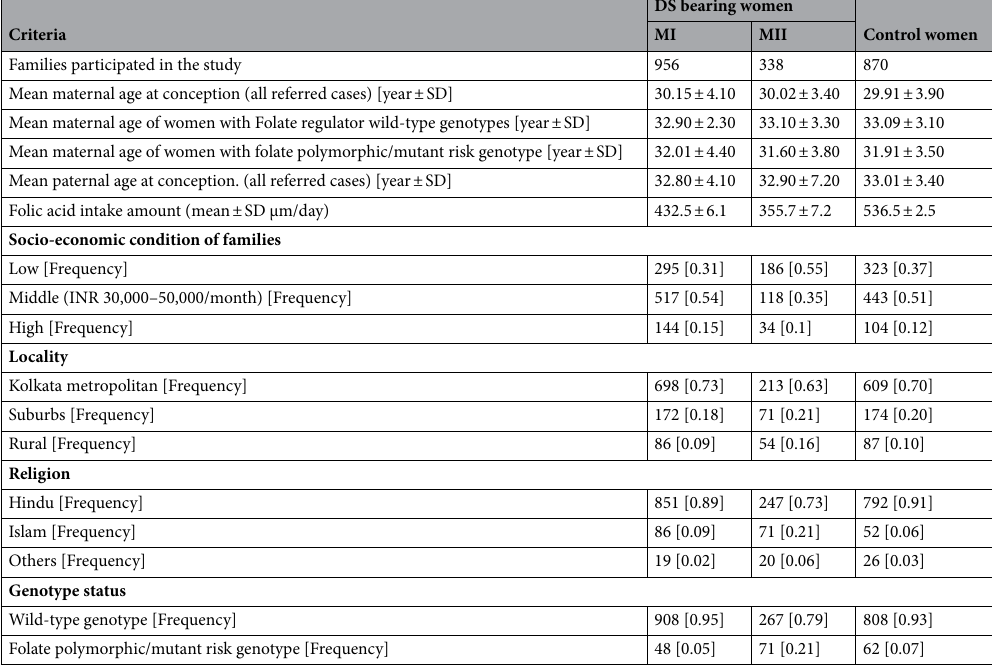
Frequency of folate regulator polymorphism in case–control and meiotic outcome groups. We calculated frequency of all tested polymorphic variants of folate metabolic regulators and considered the moth- ers who bear any of the four tested polymorphisms together as a group and found ~ 5 folds increased odds in favour of case mothers over the controls (OR = 5.338; CI = 4.015–7.097; P < 0.0001). Out of the 1294 case moth- ers 956 and 338 were detected as MI and MII error categories, respectively. We have tested all four polymorphic polymorphic variants exhibited strong association with maternal meiosis II NDJ error and this reconfirms the result that we obtained in our previous study 27 . However, frequencies of all four polymorphic variants were esti- mated negligible in the MI NDJ group and so we considered only the MII group as the ‘case sample’ for further analyses that include association study (Supplementary Table S3) and logistic regression modelling. Some of the participating women carried more than one tested folate polymorphic genotypes and for them we calculated synergistic effect through gene–gene interactions models for all four tested variants. All the pos- sible genotype combinations of any two given loci at a time were tested taking wild type genotype as reference (Supplementary Table S4). Further, we have designed hypothetical models to evaluate the additive risk of maternal genotypes in com- bination with all the tested variants (Supplementary Table S5) and found gradual increase in risk of DS birth with increasing number of risk alleles in the tested loci. When all four loci carry risk alleles together either in homozygous or heterozygous state in the tested models, a ~ 17 folds odds in favour of MII errors was evident ( P < 0.0001). When three out of four loci carried respective minor allele together, we estimated ~ 9 folds increased odds in favour of MII error ( P < 0.0001). Interactions among risk factors. We stratified the participating case mothers into three age categories, based on maternal age at the time of conception following our previous definition 5 : young age group (≤ 28 years), middle age group (29–34 years) and old age group (≥ 35 years). For all the analyses, the maternal age of concep- tion was considered as proxy for oocyte age as direct estimation of the later was beyond the scope of the present study. We used binary logistic regression and linear regression models to study a variety of questions regarding interaction among genetic risk factors i.e., amount of recombination, location of recombination, folate regulator gene mutations and epidemiological risk factor i.e., maternal SCT use and their association with maternal age